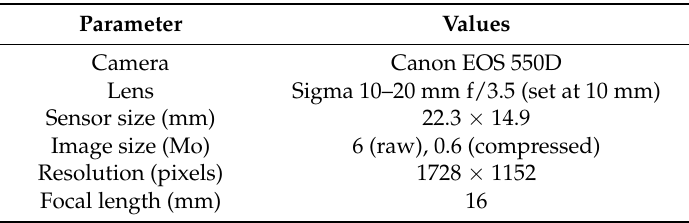
Table 1. Specifications of the camera.